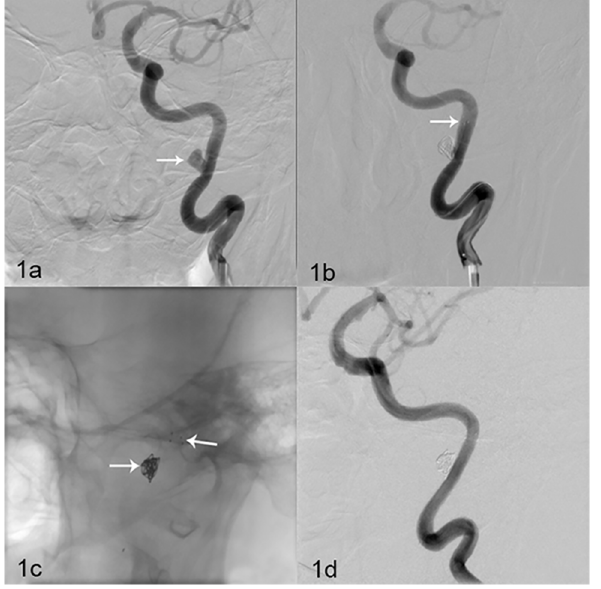
patency. (c-d) DSA at the 6-month follow-up revealed no aneurysm development, and revealed parent artery patency.